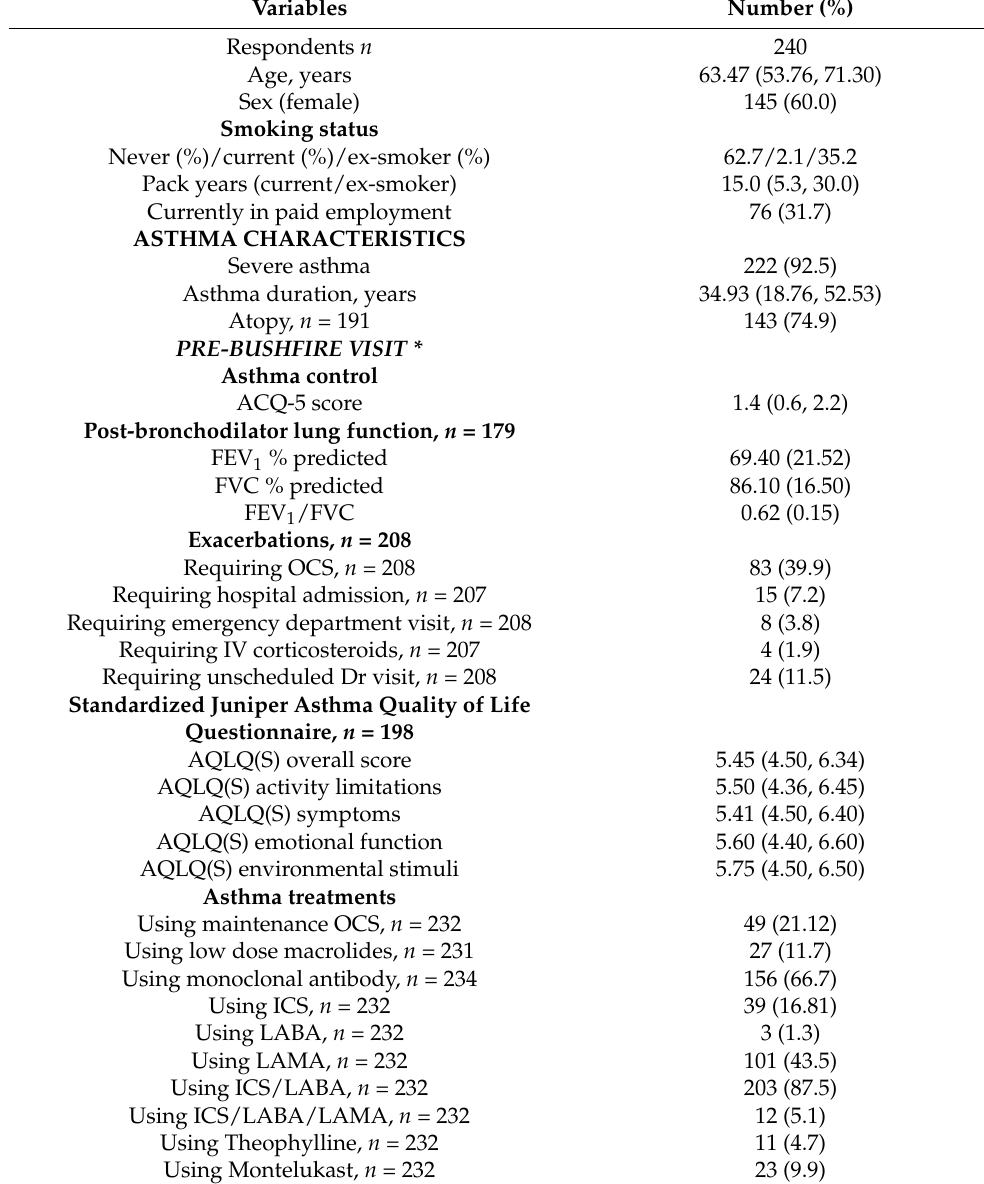
Table 1. Demographic and clinical characteristics of study